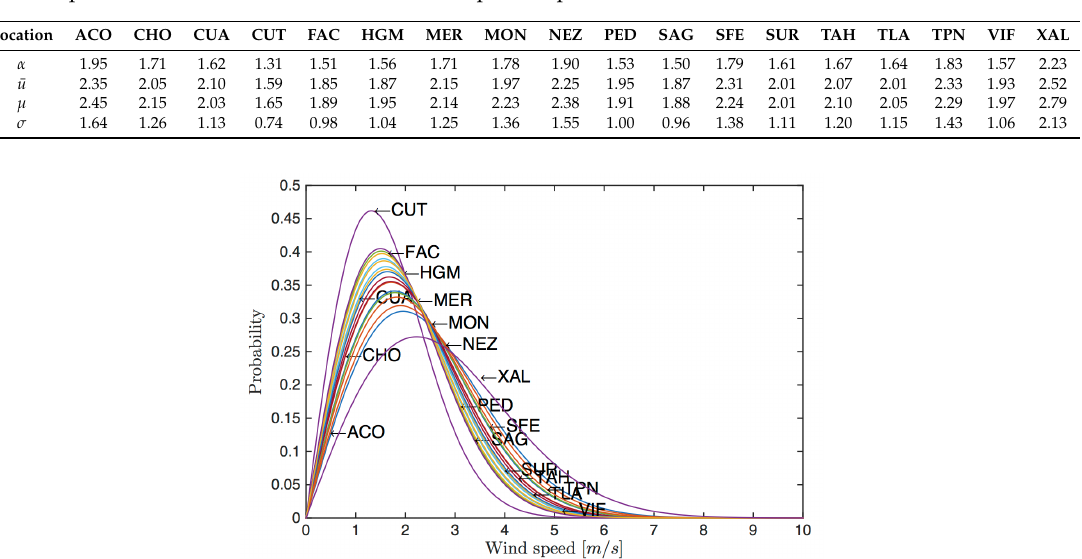
Figure 4. Rayleigh probability functions were fitted to every anemometric station in order to verify the adequate model representation. Probability plots were developed between the cumulative distribution function (CDF) and real data. Due the large number of locations, two typical plots obtained among the sites were selected to illustrate the goodness-of-fit criterion. Table 2. Parameters of statistical models fitted to each anemometric station. In the first column, α corresponds to the Rayleigh parameter, ¯ u represents the arithmetic mean, µ is the expected value of the probabilistic distribution, and σ is the dispersion parameter.